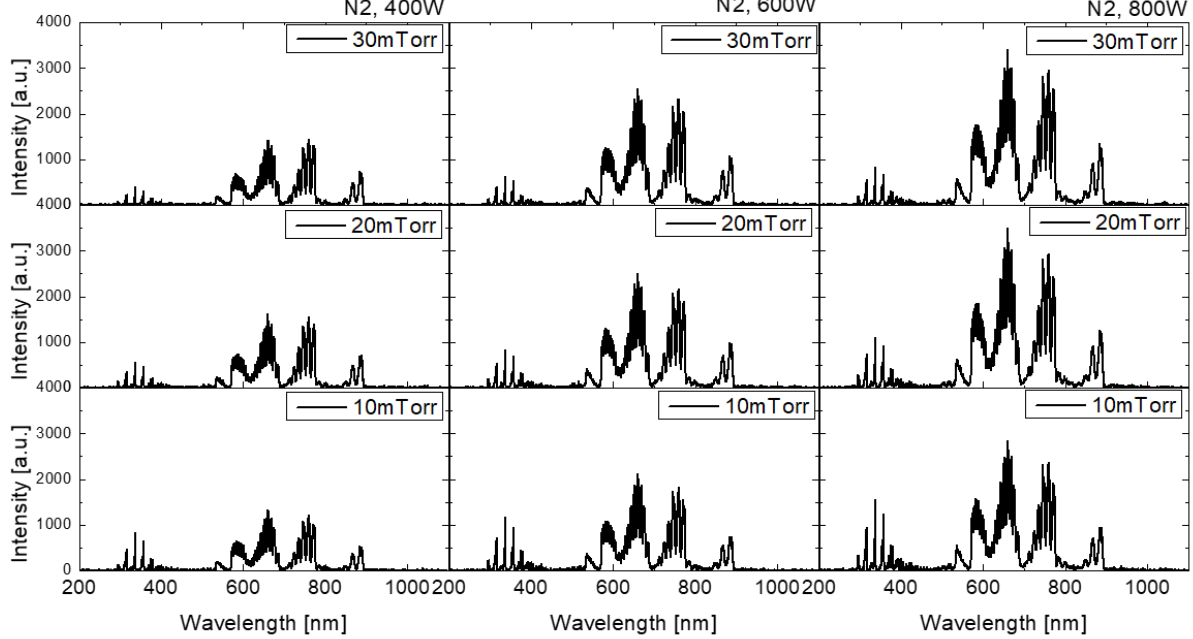
Figure 3. The OES spectrum measured for the exciting RF frequency of 13.56 MHz at 10, 20, 30 mTorr and 400, 600, 800 W.